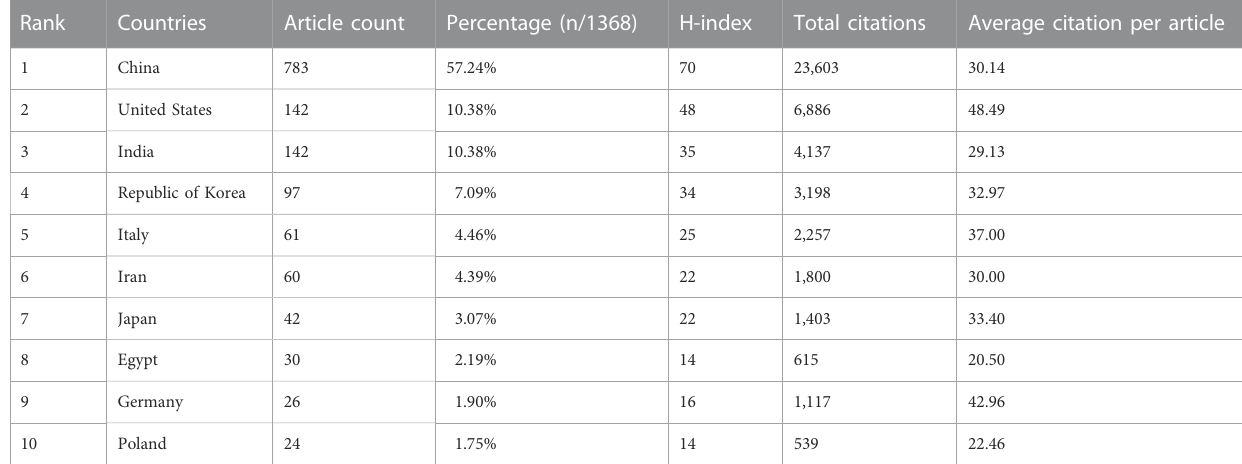
TABLE 1 Top 10 countries that contributed publications on BBR and